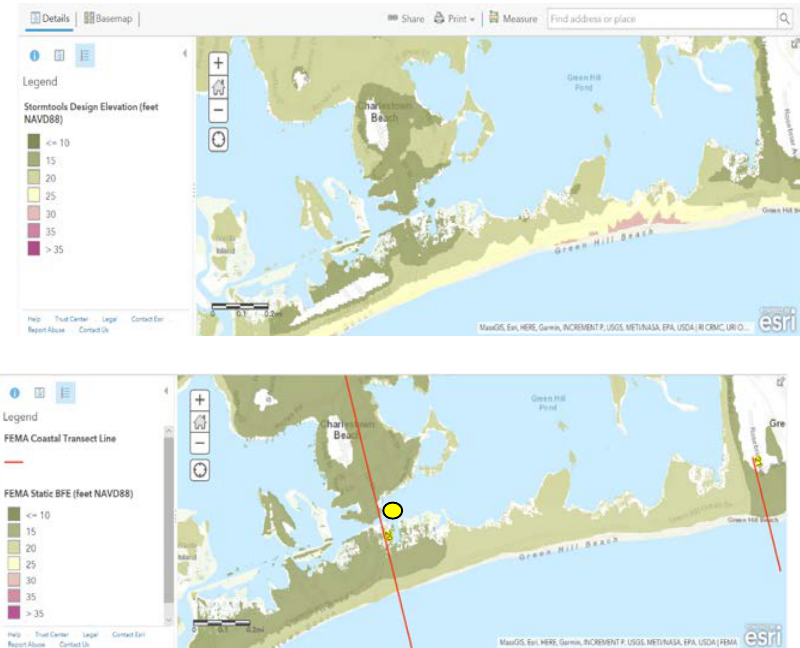
Figure 9. Comparison of SDE (upper panel) vs. FEMA FIRM (lower panel) BFE maps for the 100-yr, no-SLR case. Yellow dot indicates the location of the comparative analysis shown in Table 2. Table 2. Comparison of surge depth, wave height, and SDE values (ft, m) at two selected locations vs. 1% water level with sea level rise (SLR).